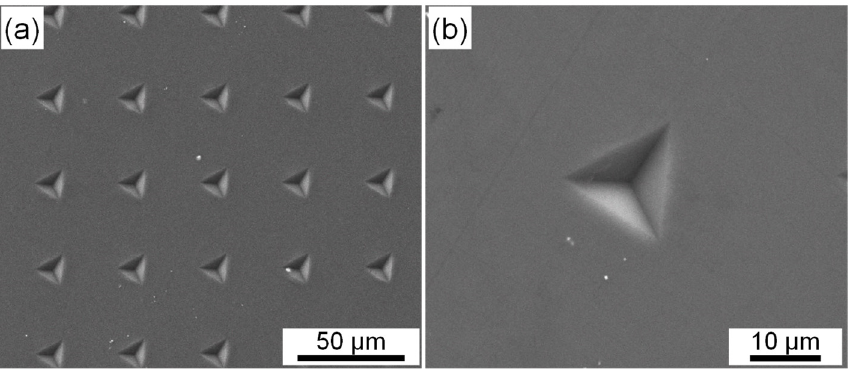
Figure 12. SEM images of indentation morphology showing no microcrack: ( a ) low and ( b ) high